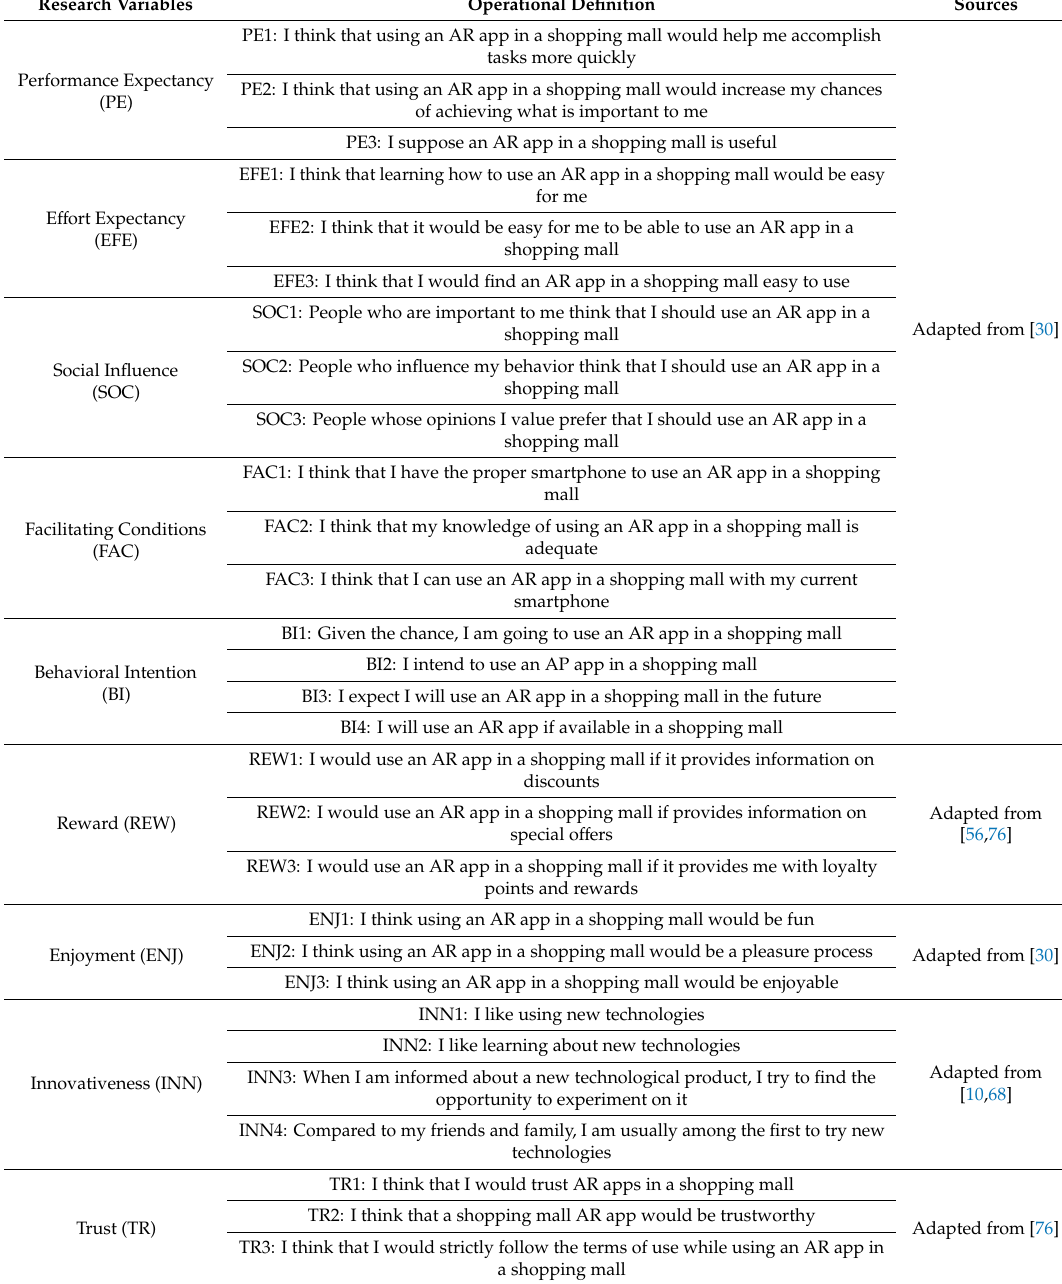
Table 2. Operational definition of research